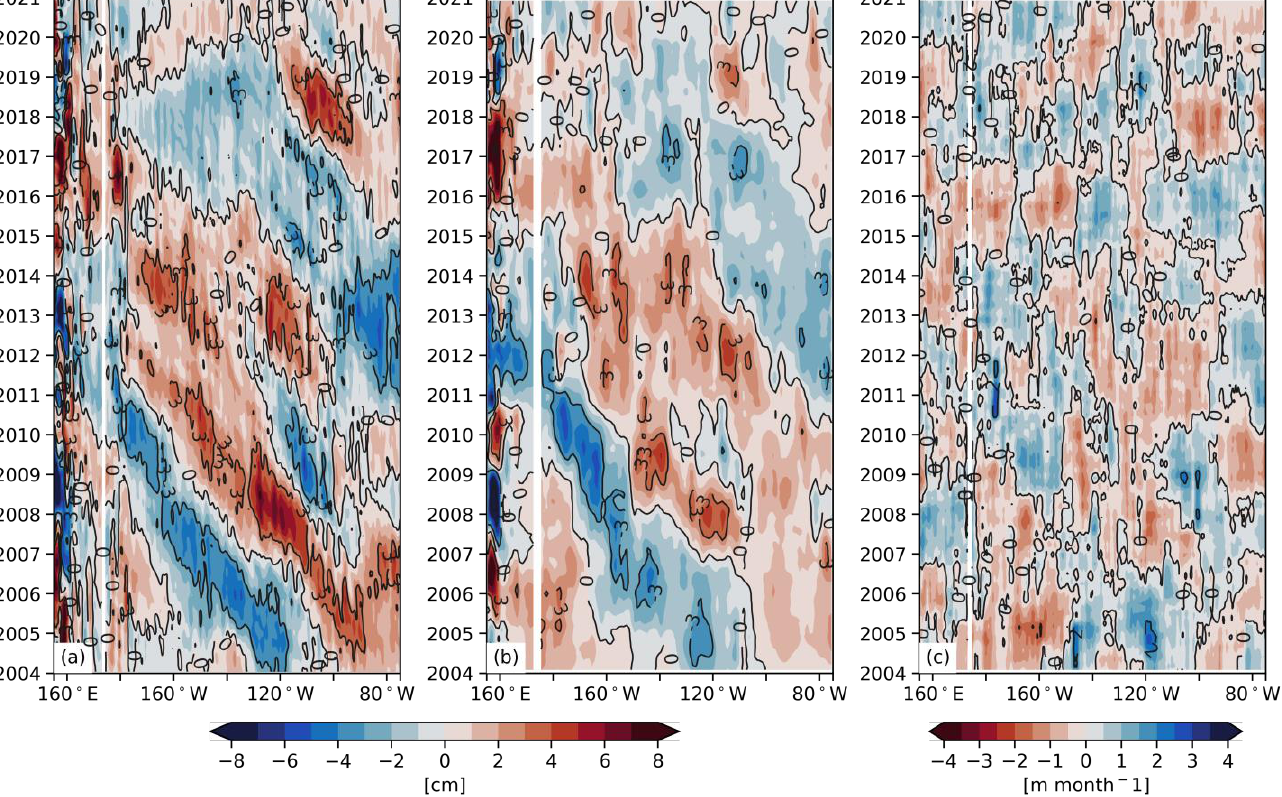
Figure 8. ( a ) Time-Longitude diagrams from 155 ◦ E to 75 ◦ W at 35 ◦ S (by averaging over 34 ◦ –36 ◦ S) in the South Pacific during 2004 – 2020 of ( a ) observed interannual sea level anomaly derived from altimetry, ( b ) Roemmich-Gilson Argo-based interannual thermosteric sea level and ( c ) interannual Ekman pumping anomaly (positive upward). To emphasize on local changes along 35 ◦ S, the zonal mean was removed from all-time series. Contour lines (see inline numbers for intervals) are also shown.